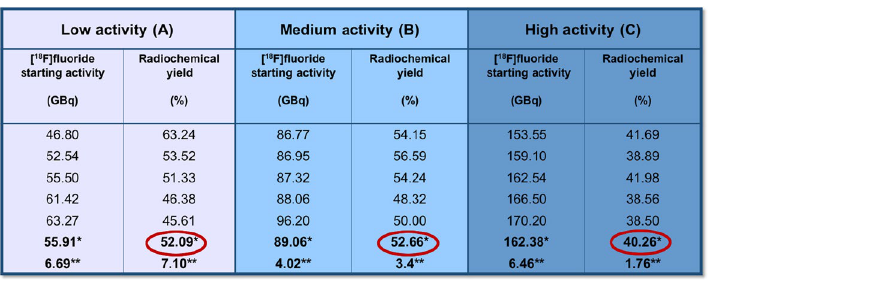
Table 1 Comparison of [ 18 F]fluoride (GBq) starting activity and related RCY( %) at EOS